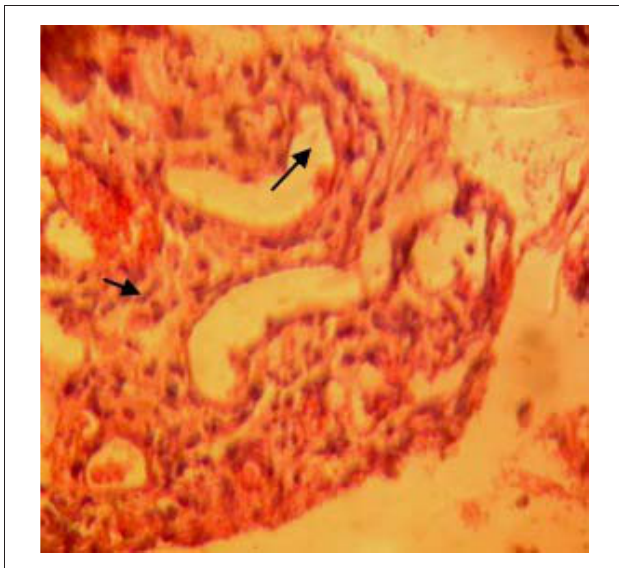
Fig. 2. Fibrotic reaction and fibroplasia in Group B. Arrows point to angiogenesis of the tissue. (X 400- H & E